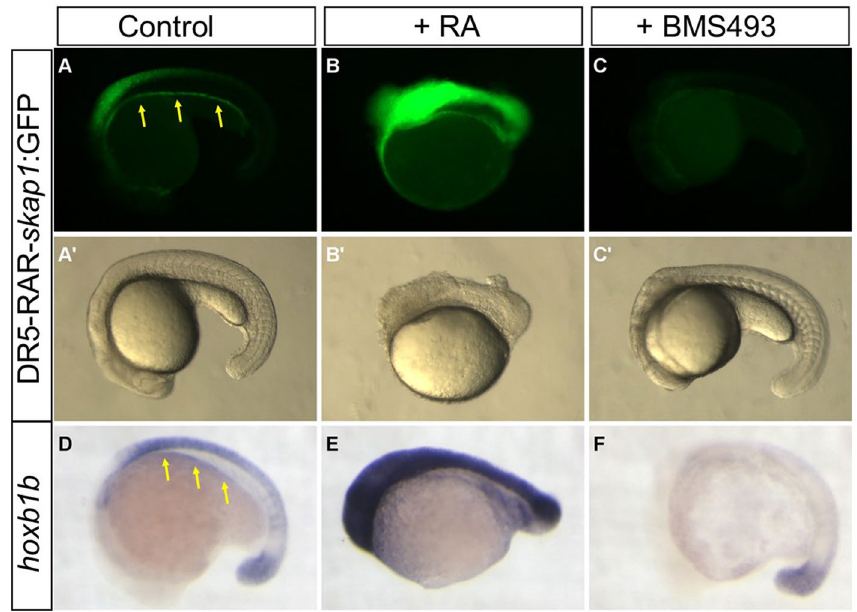
Figure 5. The conserved RAR site from skap1 gene 4th intron is a functional RARE. Pictures of the DR5-RAR- skap1:GFP transgenic embryos treated with DMSO (control, panel A ), with RA (panel B ) or with BMS493 (panel C ). Upper panels display GFP fluorescent expression and lower panels ( A ′ , B ′ and C ′ ) display embryo morphology. GFP Expression in the posterior endoderm gut is indicated by yellow